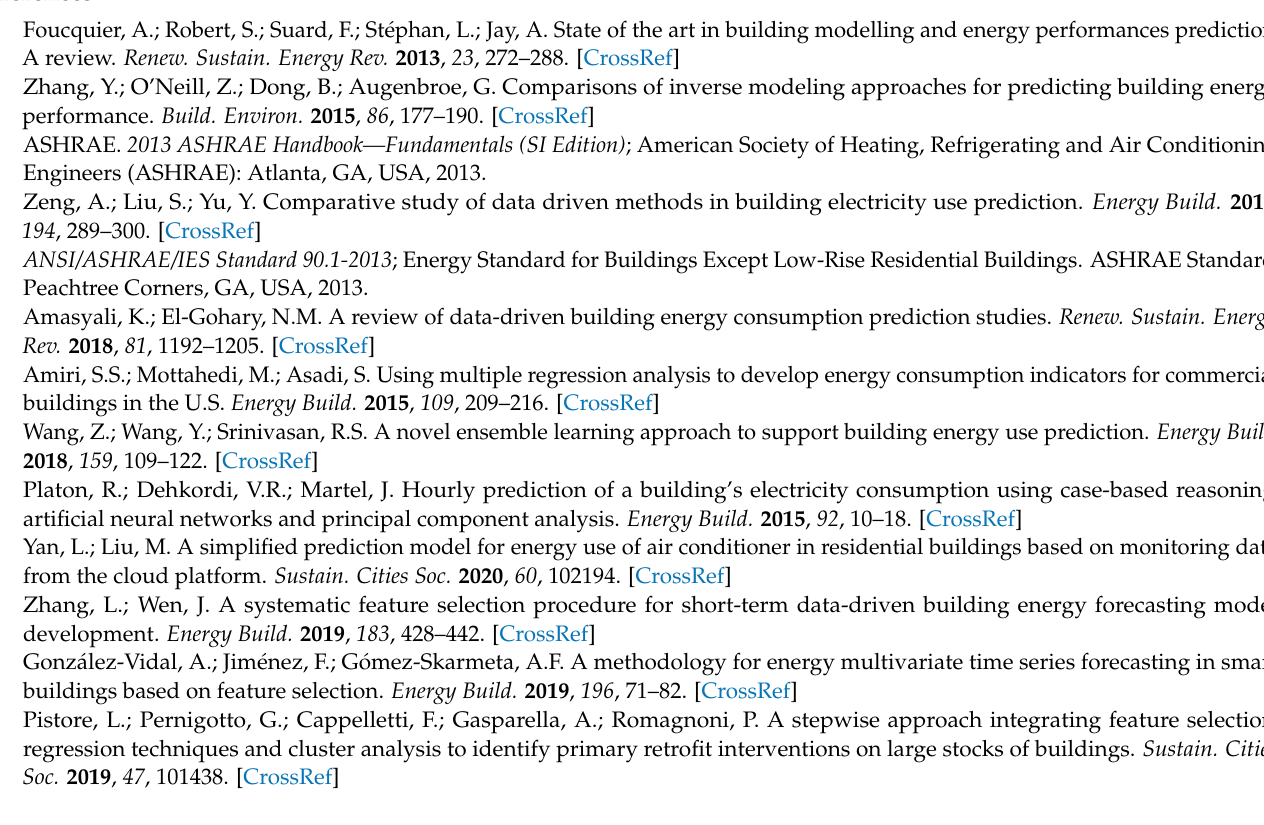
Figure A3. ( a ) Building shape and ( b ) floor layout of Case 2 (an office located in California, USA).